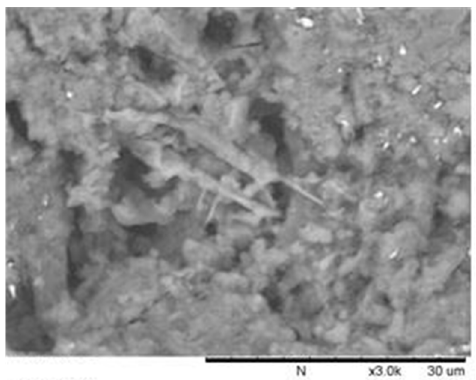
Figure 12. SEM image of a fractured OPC piece from parts adjacent to steel, showing needle-like crystal structures.